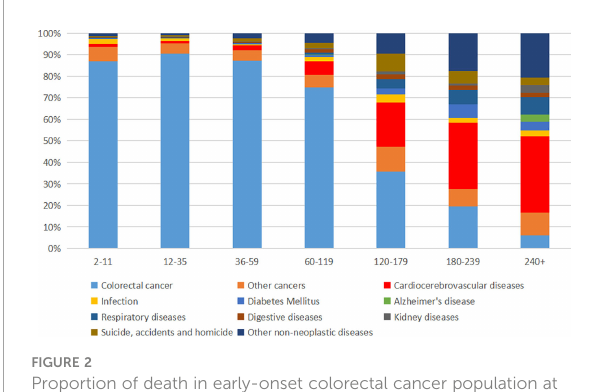
FIGURE 2 Proportion of death in early-onset colorectal cancer population at different follow-up